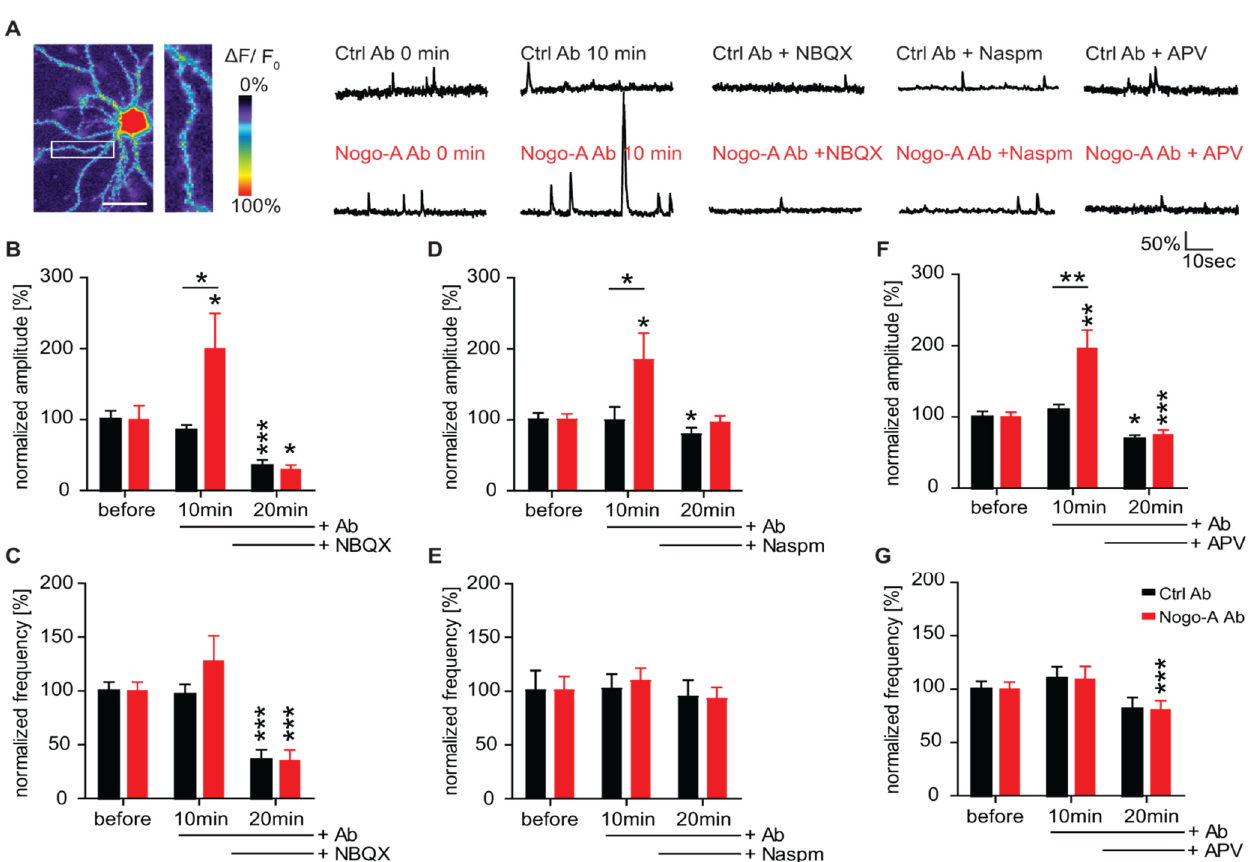
Figure 3. Nogo-A neutralization results in a calcium permeable-AMPAR dependent increase in Ca 2+ dynamics. ( A ) Representative pseudo-colored image for Ca 2+ response of a GCaMP5g transfected neuron. Scale bar 10 µm. Zoomed in region of the cell (white square) shows fluorescence intensity change of dendritic spines according to the heat map. The fluorescence intensity change ( Δ F/F 0 ) is displayed for 0–100%. Ca 2+ -imaging traces upon Nogo-A loss-of-function (red, bottom) or the control condition (black, above) both before (0 min) and after the antibody treatment (10 min) and the additional blocking of AMPARs (NBQX), CP-AMPARs (Naspm) or NMDARs (APV). The percentage change in fluorescence intensity over time is illustrated. Scale bars are 50% vertical and 10 sec horizontal. ( B – G ) Normalized change in Ca 2+ transient amplitude and frequency upon either control (black) or Nogo-A function-blocking (red) antibody. Antibody treatments were performed for a total time of 20 min with additional wash-in of NBQX (B, C; Ctrl Ab: n = 11; Nogo-A Ab: n = 11), Naspm (D, E; Ctrl Ab: n = 15; Nogo-A Ab: n = 16) and APV (F, G; Ctrl Ab: n = 10; Nogo-A Ab: n = 16) for 10 min. Data are presented as mean ± SEM. * p < 0.05, ** p < 0.01, *** p < 0.001; n = number of neurons.